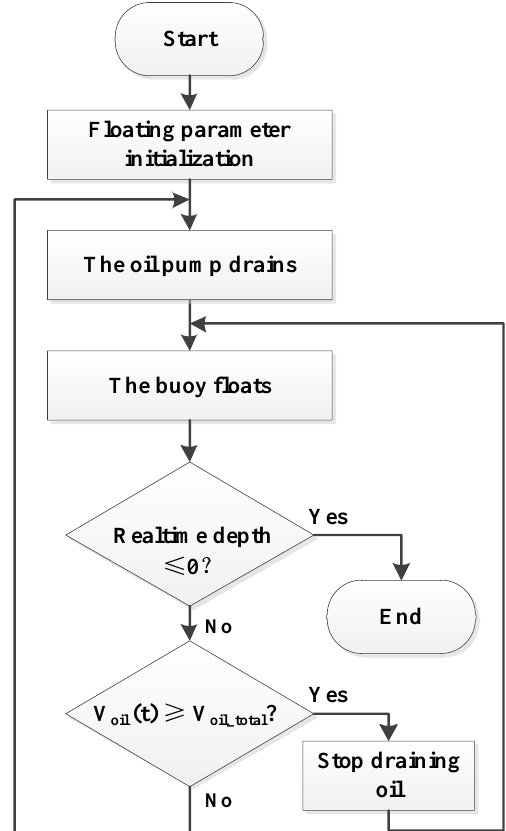
Figure 13. The one-time oil draining control mode.